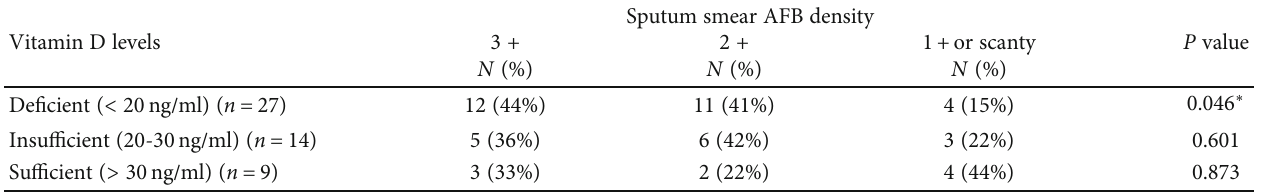
Table 4: Comparison of vitamin D levels with sputum fi ndings in pulmonary